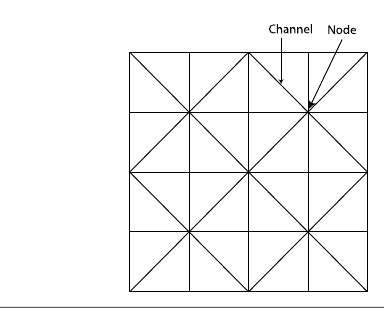
Figure 4 An illustration of a triangular network